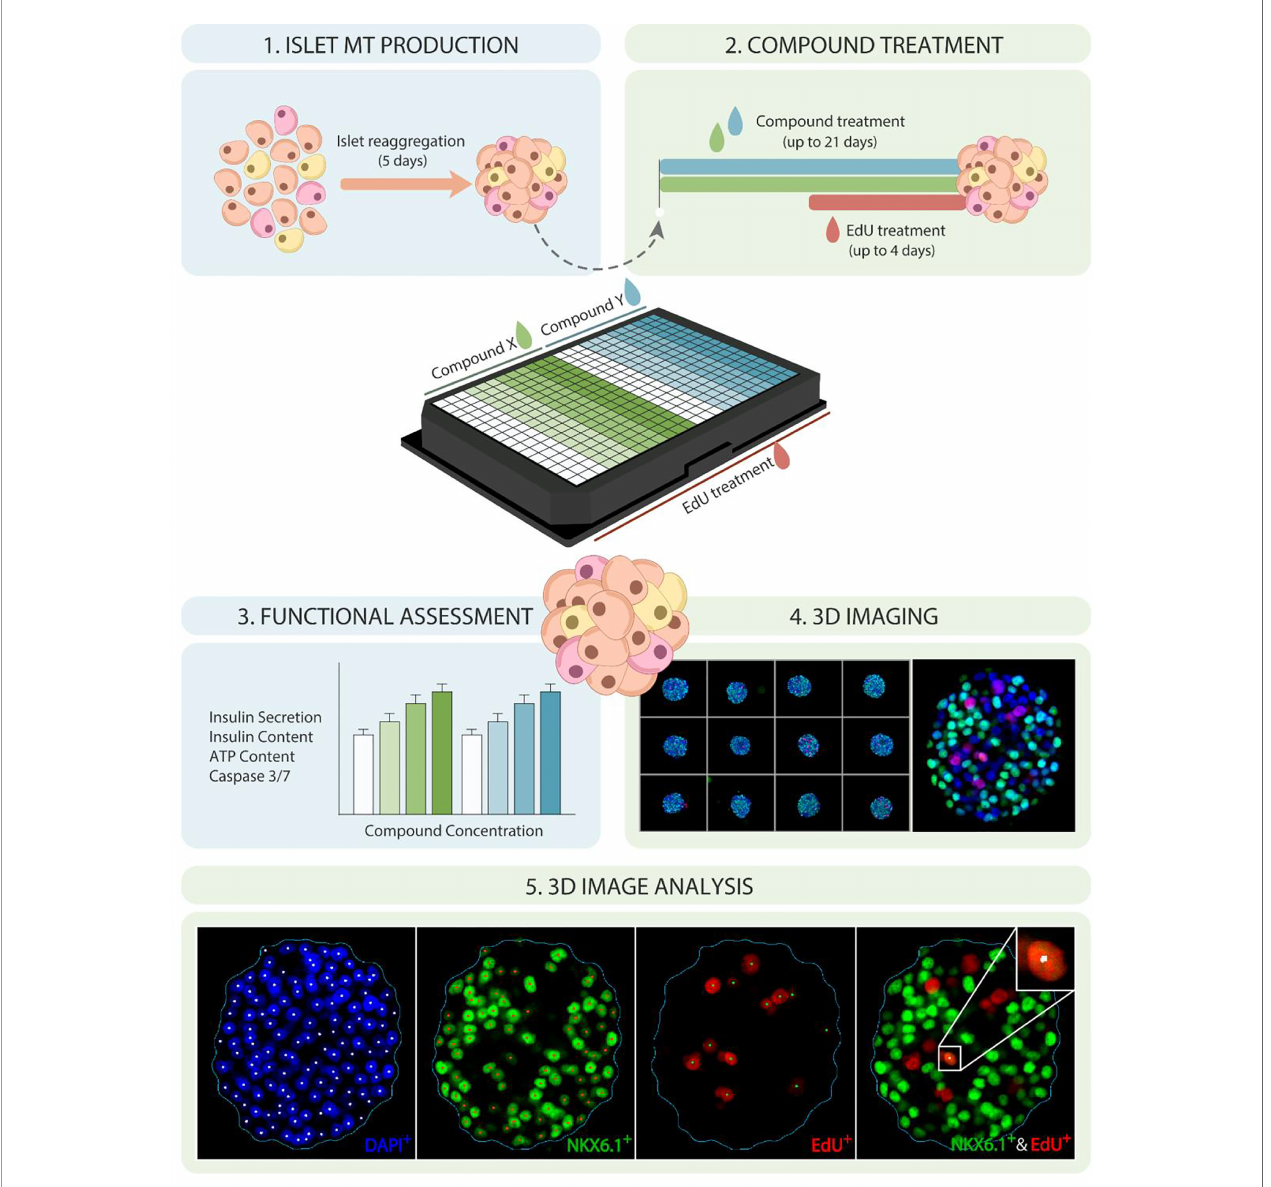
FIGURE 1 | Establishing a high-throughput platform for evaluating b -cell proliferation and function in human islet MTs. Schematic representation of experimental timeline and platform for 3D evaluation of b -cell proliferation and function in human islet MTs. Dispersed islets are reaggregated into islet MTs for 5 days, followed by proliferative compound treatment for up to 21 days, including 5-ethynyl-2 ′ -deoxyuridine (EdU) incorporation during the last 4 days of treatment. Islet MTs are then used for functional endpoints such as glucose-stimulated insulin secretion (GSIS), total insulin content, ATP content, and Caspase 3/7 activity, or fi xed with 4% PFA. Fixed MTs are stained for DAPI, EdU, and NKX6.1, and imaged with a confocal, high-content imaging system. Image quanti fi cation is then performed to quantify DAPI-, NKX6.1-, EdU and EdU/NKX6.1-positive